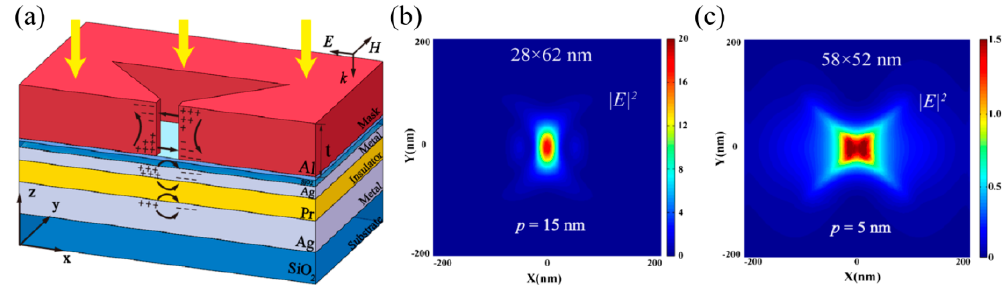
Figure 17. ( a ) Schematic structure of plasmonic lithography with bowtie aperture and plasmonic cavity lens resist recording structure; Simulation results ( b ) with cavity lens and ( c ) without cavity lens. Reproduced from [80], Copyright © 2015, Springer.